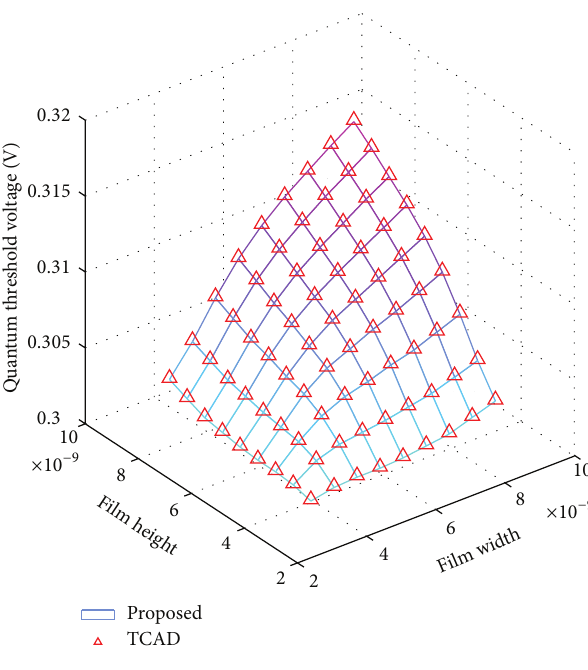
Figure 5: Variation of quantum threshold voltage with film height and width for channel length ( 𝐿 = 20